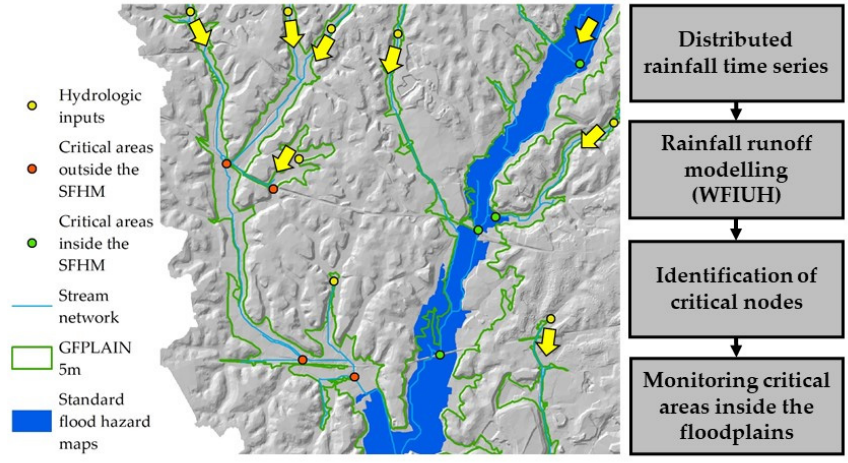
Figure 2. Scheme of the integration of the GFPLAIN dataset into a hydrologic model for real-time critical areas identification.